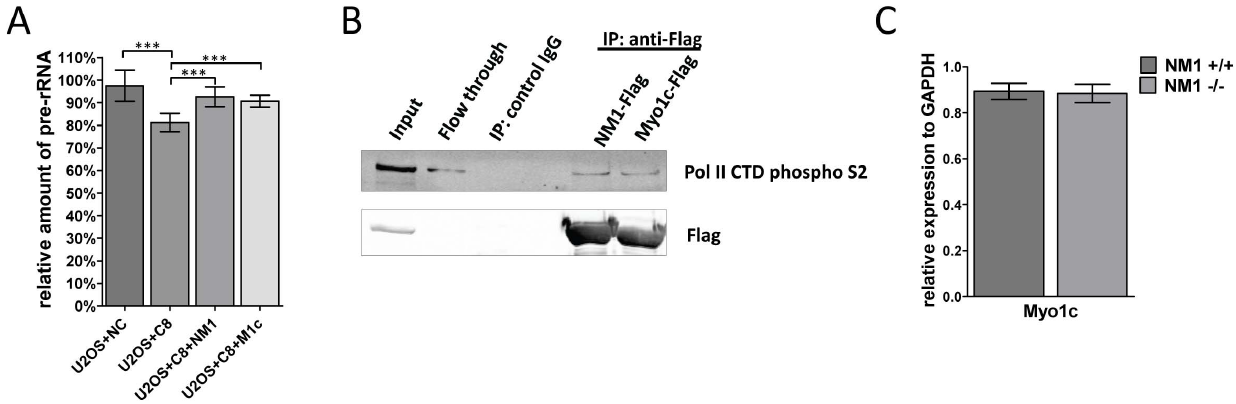
Figure 5. Myo1C is able to function in Pol I and Pol II transcription without changes in its expression level. ( A ) The level of nascent rRNA was decreased to 80% of WT levels in NM1/Myo1c knock-down cells (U2OS + C8). An overexpression of mouse NM1 (U2OS + C8 + NM1) or Myo1c (U2OS + C8 + M1c) resistant to shRNA causes restoration of Pol I transcription to almost endogenous levels. As a negative control were used U2OS cells with transduced empty pLKO1.1 vector (U2OS + NC). ( B ) Both NM1-Flag and Myo1c-Flag interact with Pol II. Extracts from cells overexpressing NM1- Flag and Myo1c-Flag were co-immunoprecipitated with Flag antibody and control IgG. Immunoprecipitates were analyzed by western blotting with antibodies against Flag, Pol II CTD subunit and Myo1c (tail domain recognizing both NM1 and Myo1c). ( C ) NM1 knock-out does not cause compensatory changes in expression of Myo1c. Expression of Myo1c was measured by RT-qPCR and compared relative to GAPDH expression. Data are presented as mean + / 2 SD. *** p , 0.001.